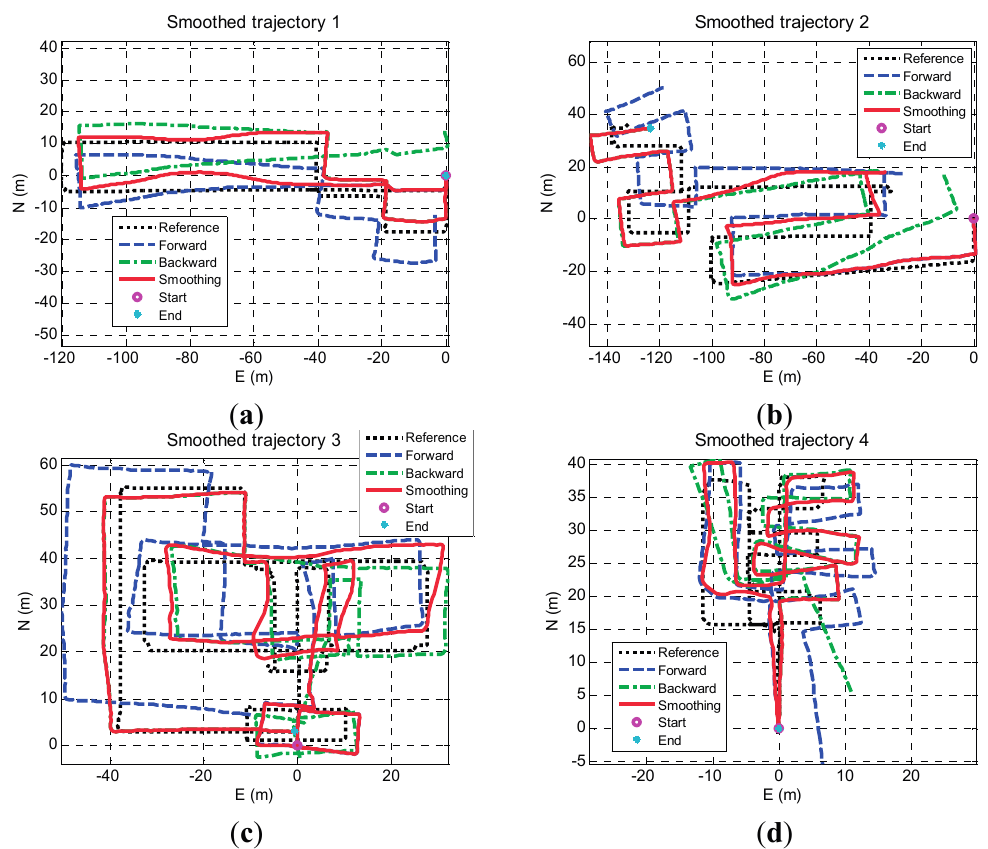
Figure 5. Sensor-based navigation solutions ( a ) Trajectory 1; ( b ) Trajectory 2; ( c ) Trajectory 3; ( d ) Trajectory